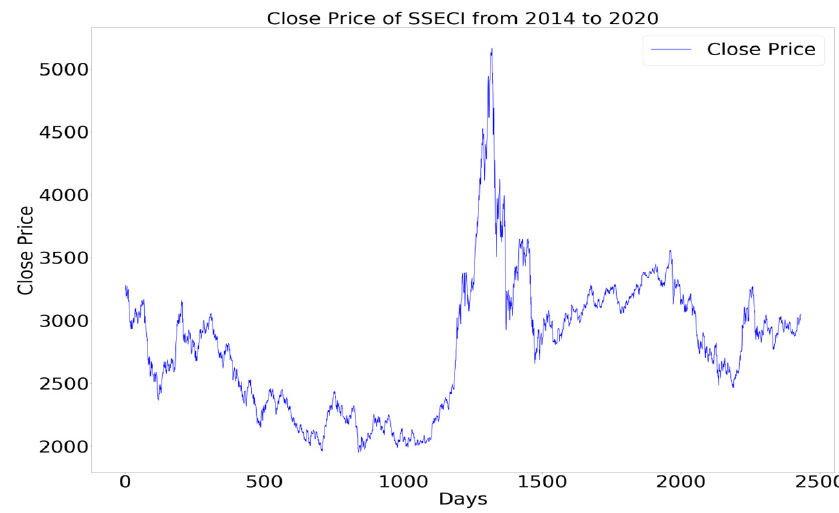
Figure 2. The graph of SSECI close price from 2014 to 2020.